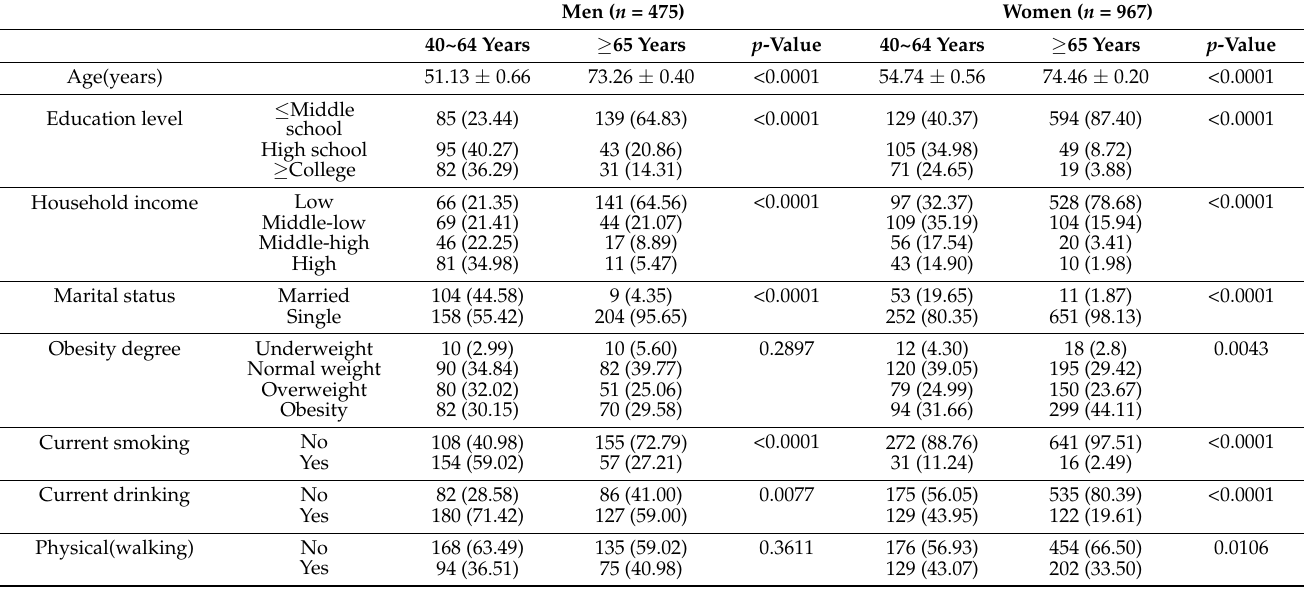
Table 1. General characteristics of study population in single-person households according to age